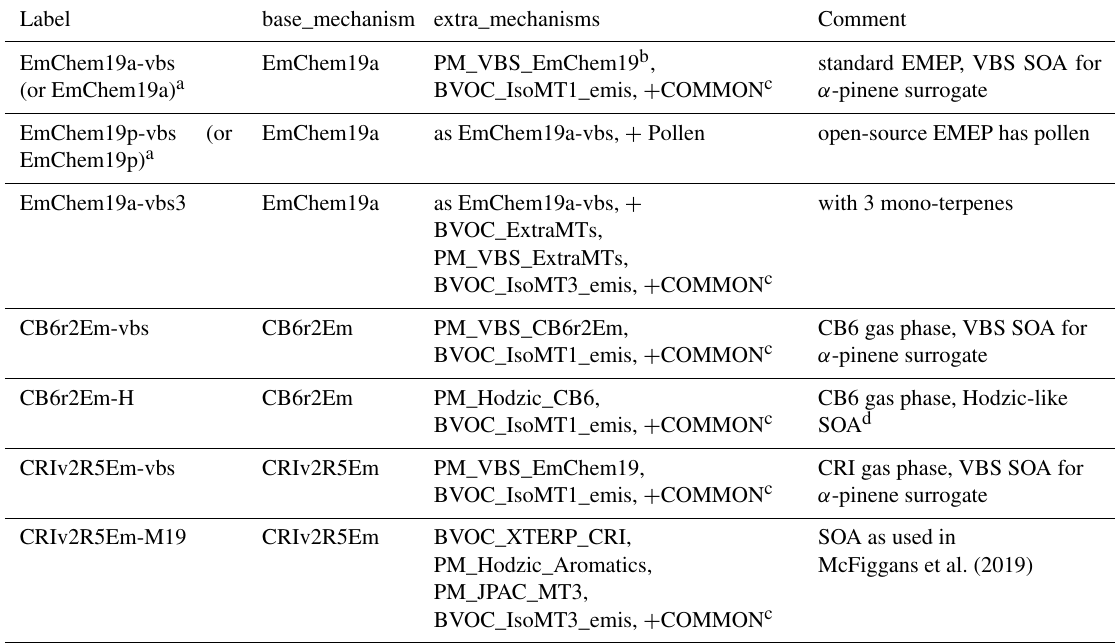
Table 5. Examples of base and extra mechanisms associated with EMEP CTM configurations (via emep_setup.py ). Label Comment